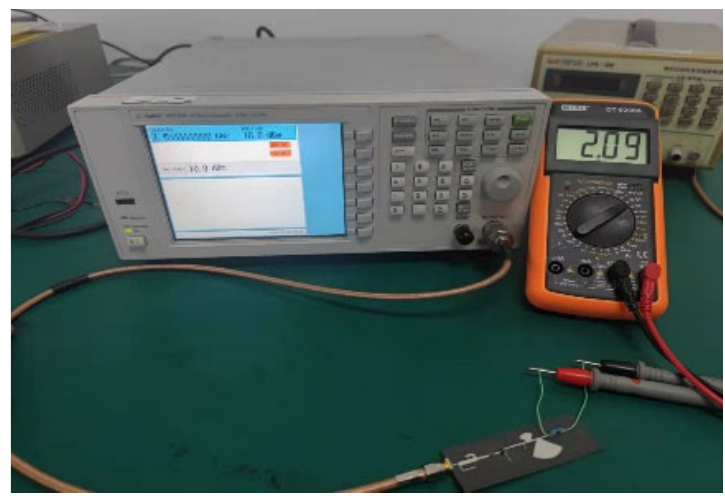
Figure 15. Conversion efficiency measurement setups.